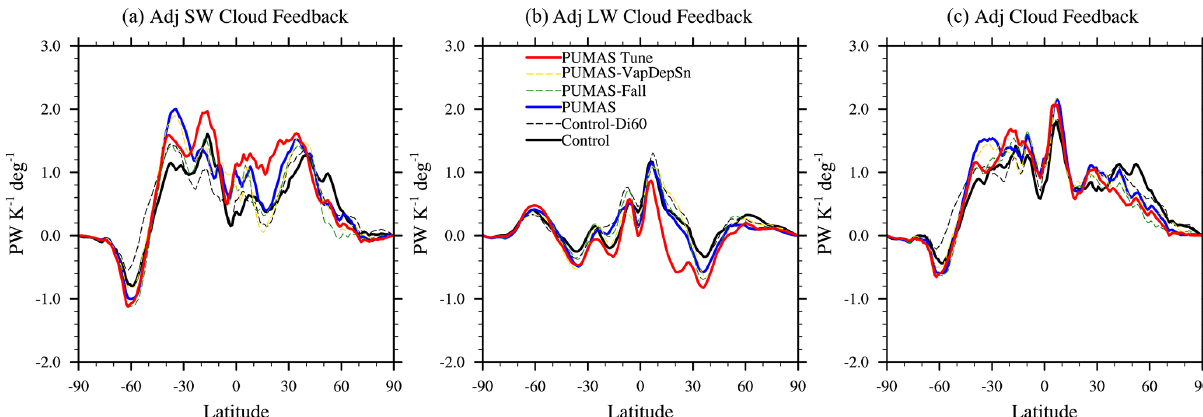
Figure 8. Zonal mean cloud feedback from SST4K simulations, with the control (black), Control-Di60 (black dashed), PUMAS (blue), PUMAS-Tune (red), PUMAS-VapDepSn (orange dash), and PUMAS-Fall (green dash) shown. Simulation names are defined in Table 1. Feedbacks use kernel-adjusted cloud radiative effects, as described in Gettelman et al. (2013) and Gettelman et al. (2019b). Results are shown for (a) SW cloud feedback, (b) LW cloud feedback, and (c) net (LW + SW) cloud feedback. Table 3. Global average forcing change due to the aerosol of PD–PI (Wm − 2